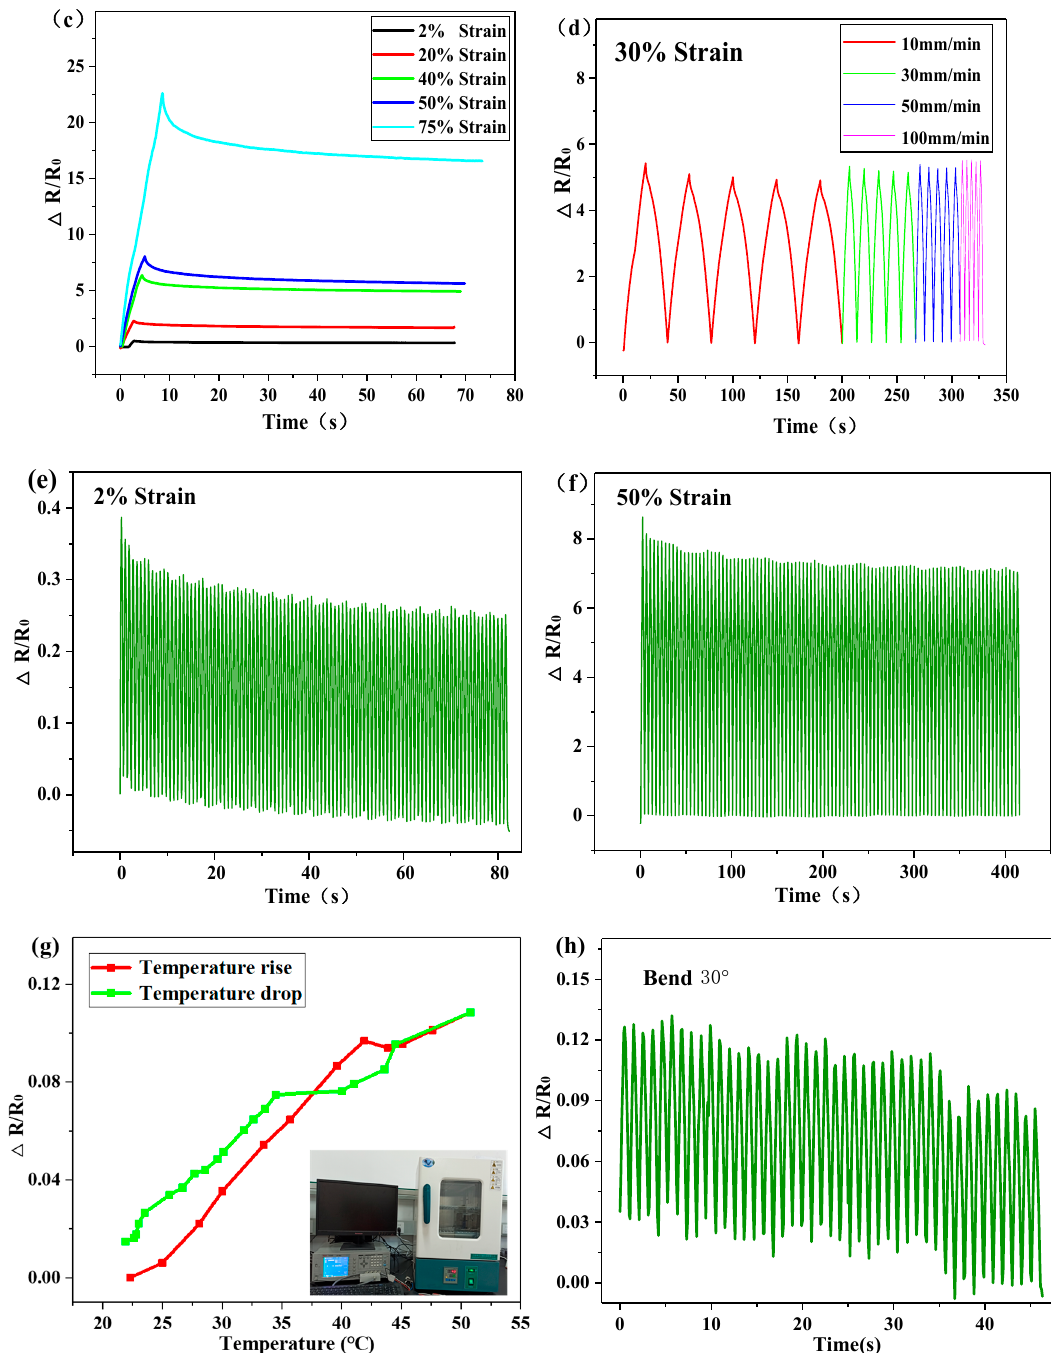
Figure 6. Performance tests of the flexible strain sensor: ( a ) changes in resistance with variations in strain; ( b ) multi-cycle testing of the sensor at different strain levels (2%, 25%, 50% and 75%); ( c ) sensing performance of the sensor at different strain rates at a strain of 30%; ( d ) relative resistance variation for step strain; ( e ) relative resistance variation curve of the sensor for 100 consecutive cycles at a strain of 2%; ( f ) relative resistance variation curve of the sensor for 100 consecutive cycles at a strain of 50%; ( g ) relative resistance variation of the sensor at varying temperatures; ( h ) the relative change in resistance in a cyclic bending test.